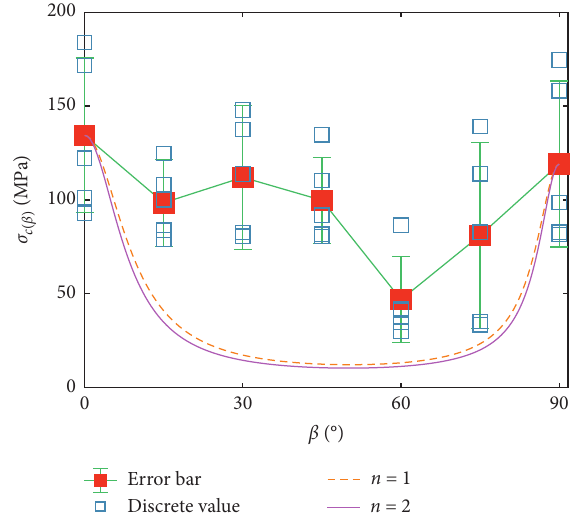
Figure 3: Variations of UCS with orientation angle β and various values of m and l .